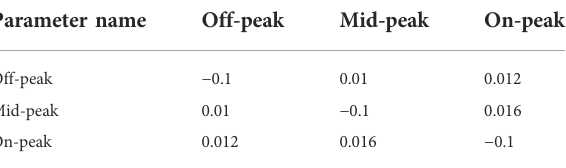
TABLE 4 Electricity price elasticity matrix